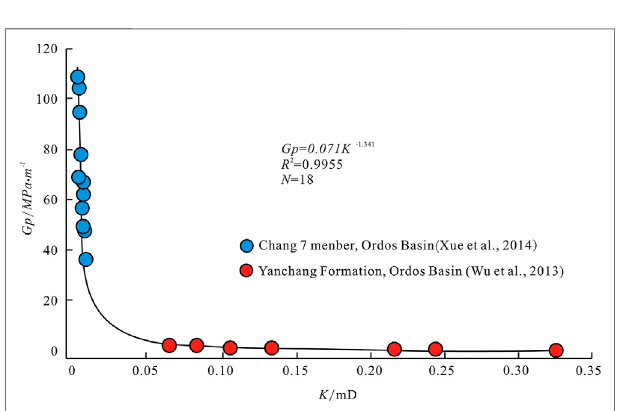
FIGURE 9 | Correlation between the start-up pressure gradient and permeability of the Yanchang Formation in Ordos Basin.